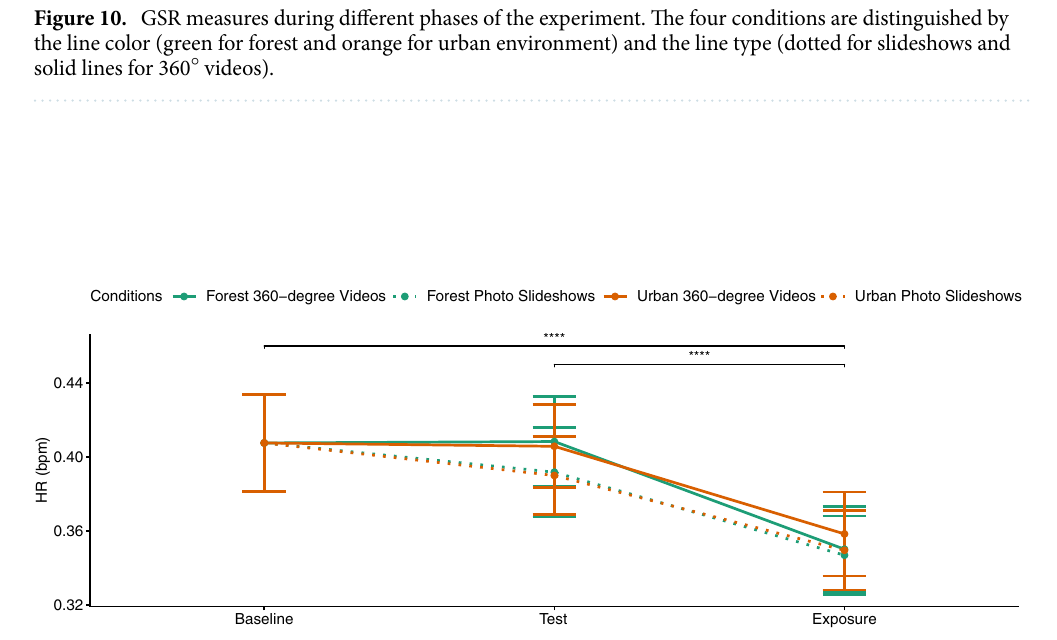
Figure 11. HR measures during different phases of the experiment. The four conditions are distinguished by the line color (green for forest and orange for urban environment) and the line type (dotted for slideshows and ◦ solid lines for 360